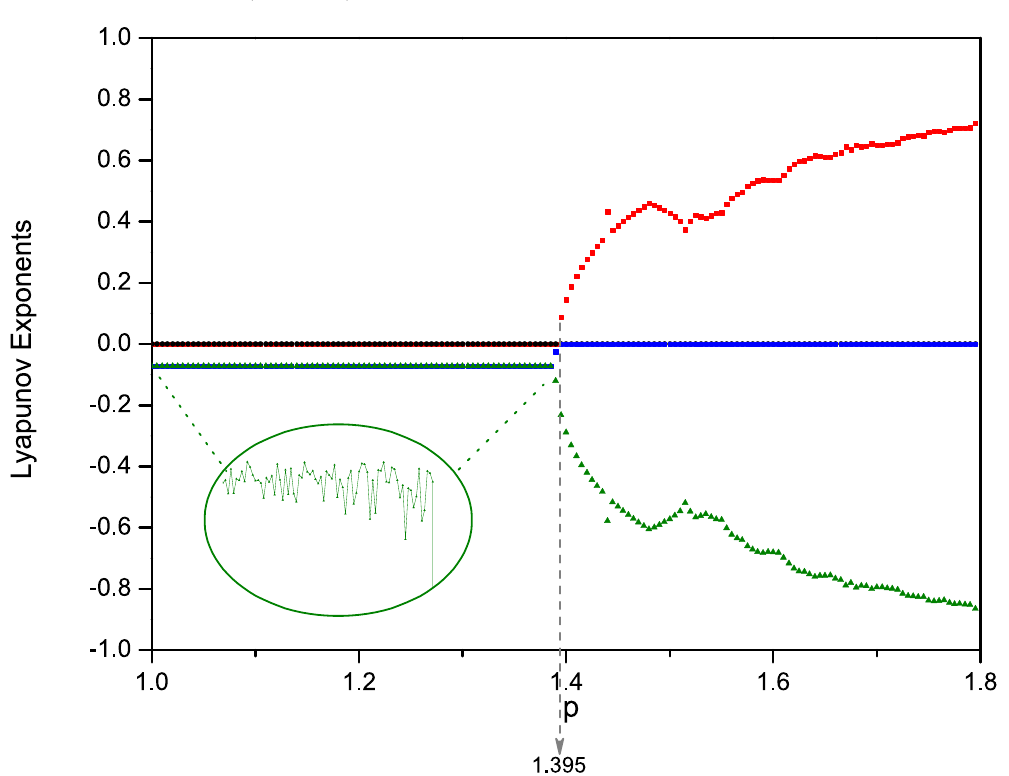
Figure 8. Lyapunov exponents against forcing amplitude p at fixed parameter conditions, ω = 1 , ω = 2 . 0 , ω = 0 1 2